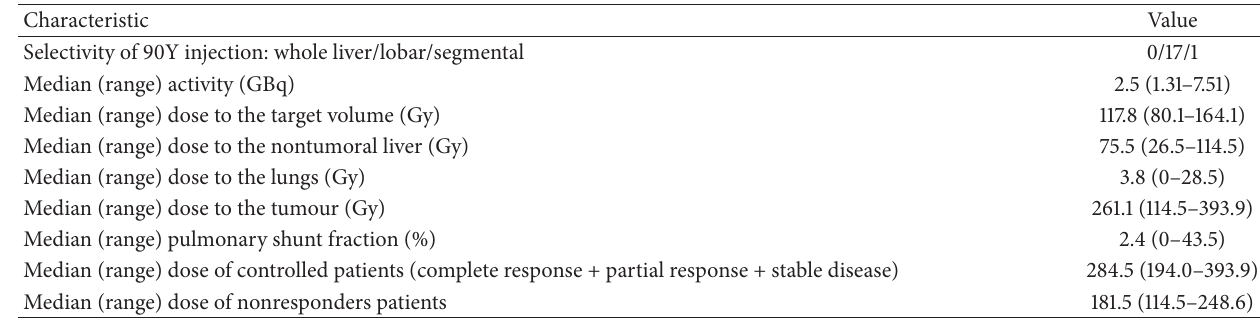
Table 2: Treatment characteristics.